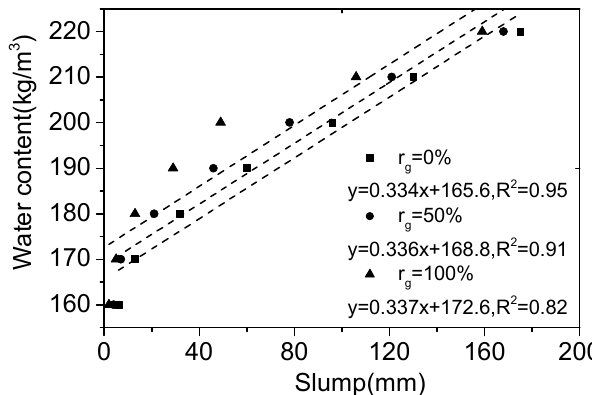
Figure 3. Relation between water content and slump of RCAC.